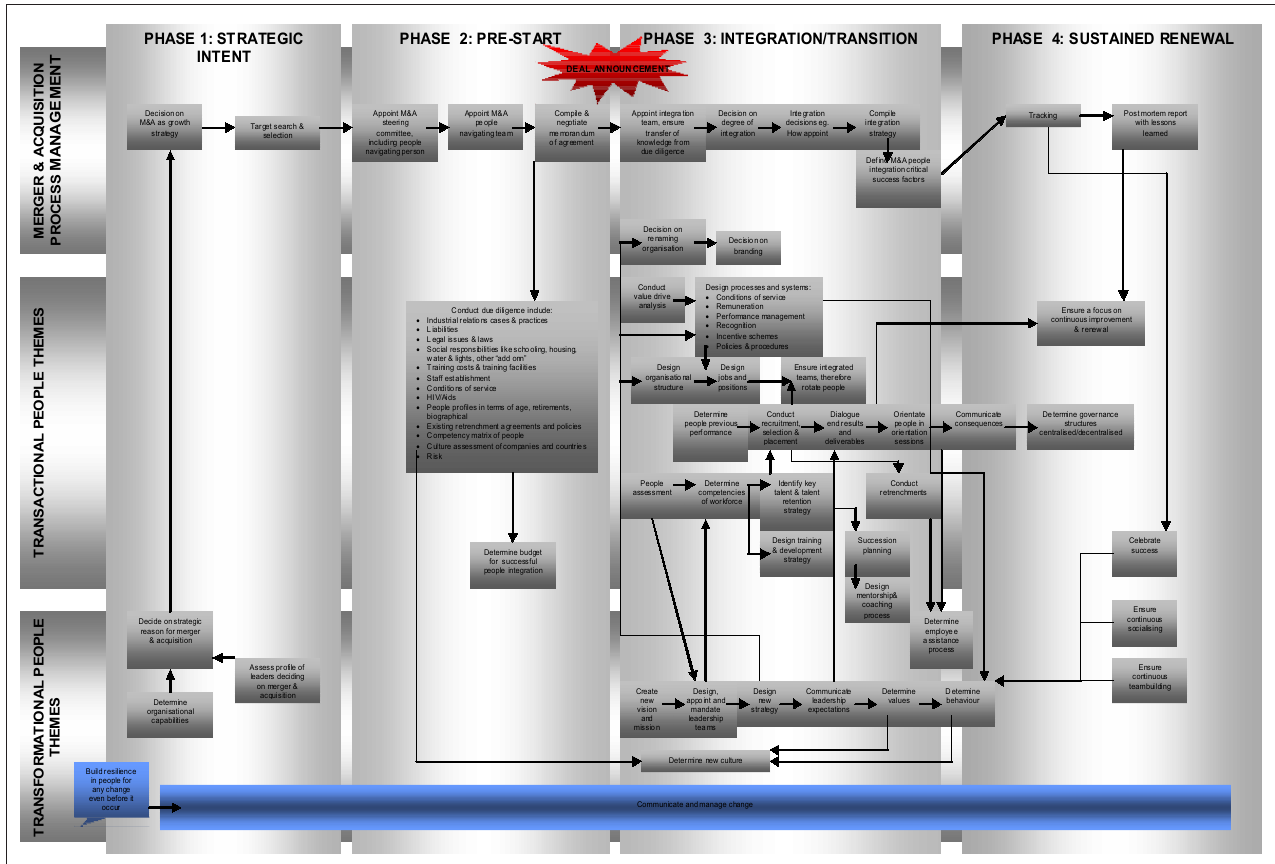
FIGURE 1: Model P reflecting best/leading M&A as sourced from